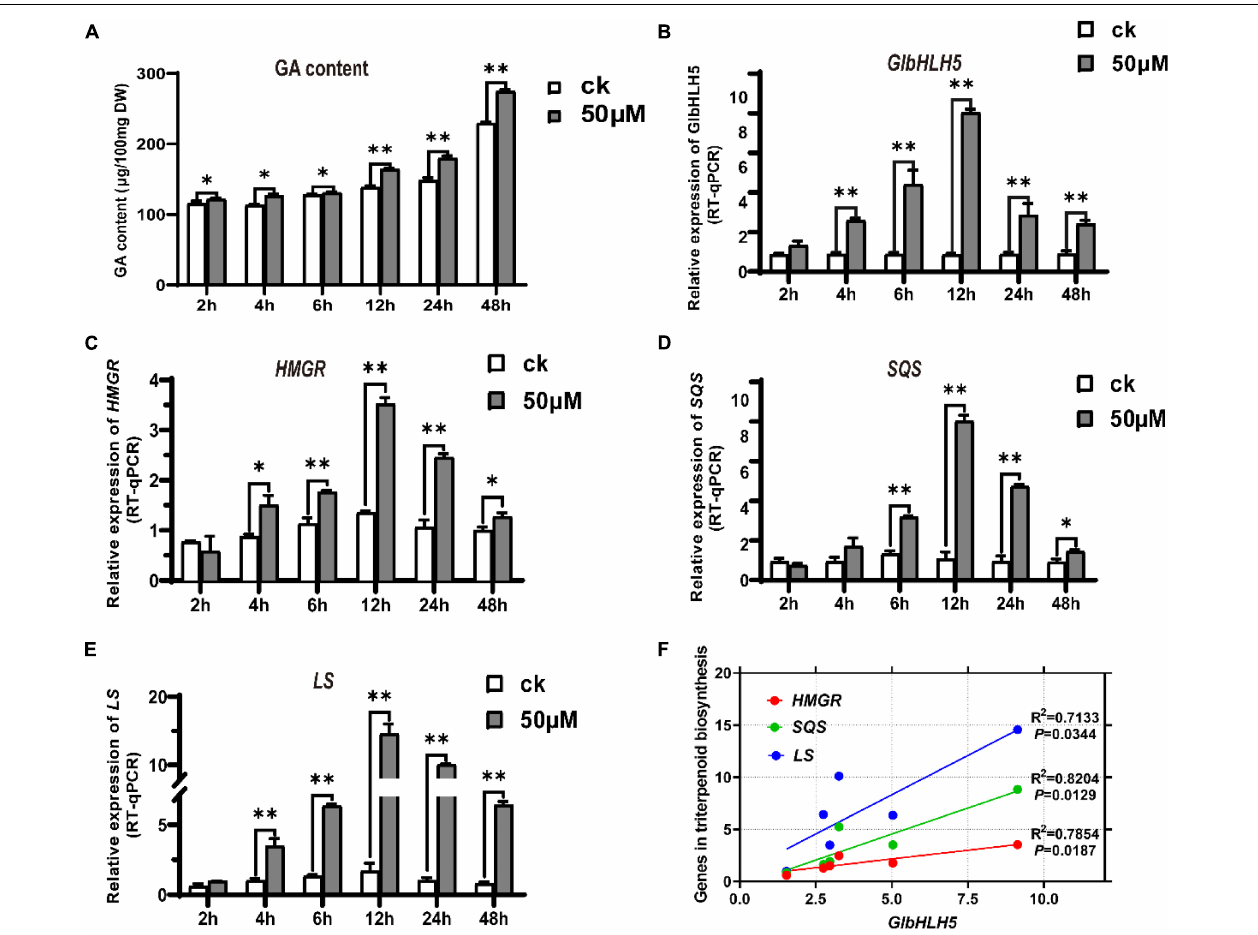
FIGURE 4 | MeJA induced triterpenoids accumulate and expressions of GlbHLH5 along with key genes in the triterpenoids biosynthetic pathway in Ganoderma lucidum. (A) Changes of triterpenoids content induced by MeJA in G. lucidum . (B–E) Relative expression levels of GlbHLH5 and key genes in the triterpenoids biosynthetic pathway. (F) Correlation analysis between GlbHLH5 and key genes in triterpenoids biosynthesis pathway. “*” means the difference is significant ( P < 0.05) and “**” means the difference is extremely significant ( P <